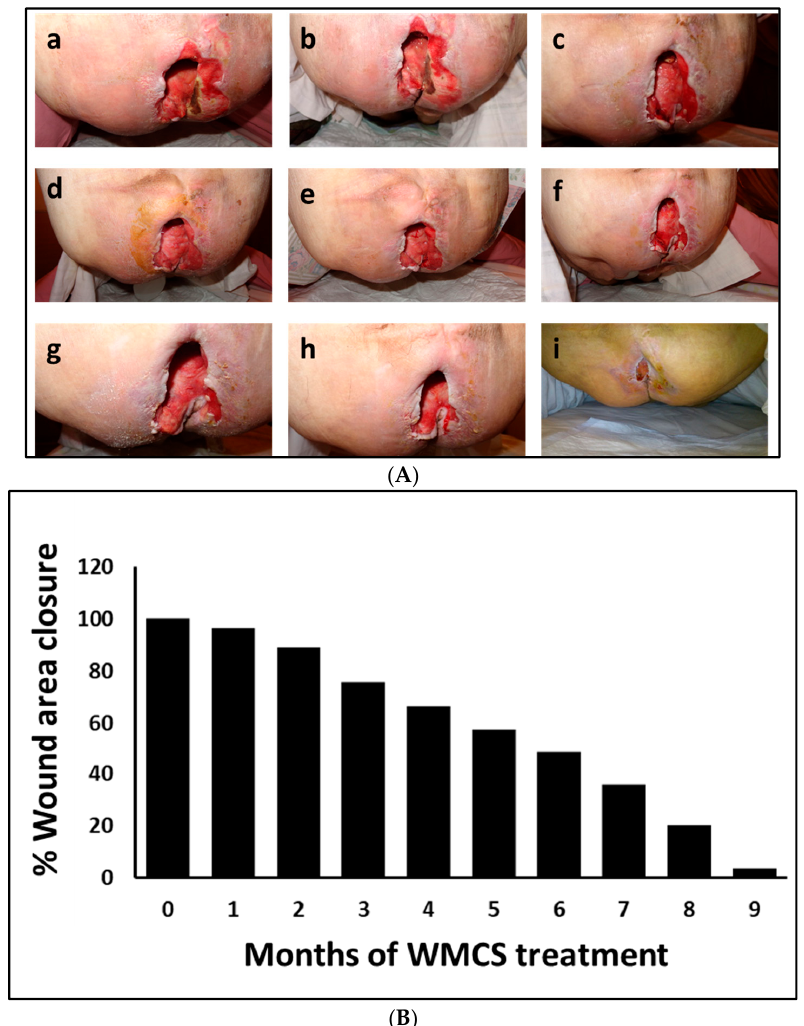
Figure 1. ( A ) (a–i): Serial photography of the clinical outcome of Patient 1 after WMCS treatment. ( B ) Presentation of photographic wound closure percentage of Patient 1. Wound healing is expressed as percentage wound area closure relative to original size [(wound area)/(original wound area)].